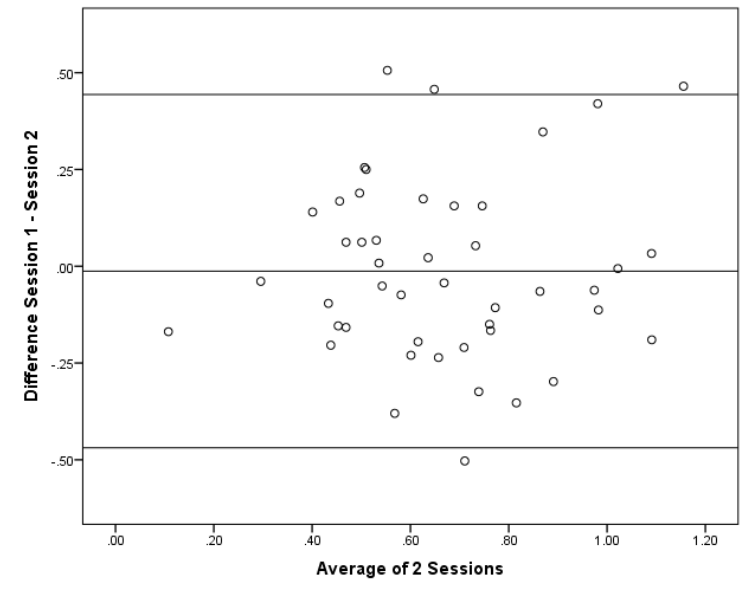
Figure 6. Bland–Altman Plot for Subgroup 2 ( n =